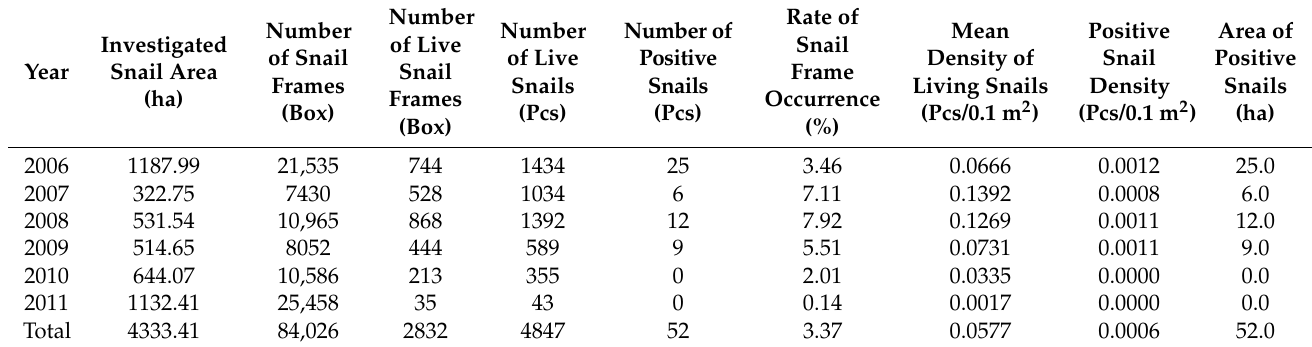
Table 1. Snail situation in the outer lake of Poyang Lake National Wetland Park from 2006 to 2011.